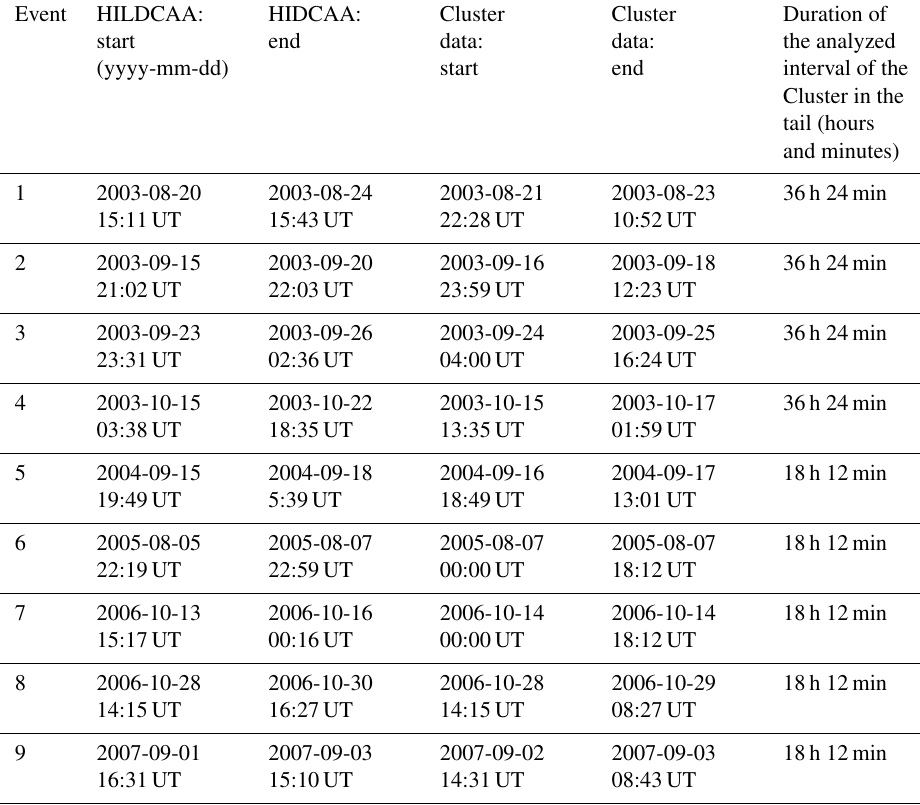
Table 1. B x geomagnetic field component data information used for the HILDCAA events analysis in the magnetotail. Event HILDCAA: HIDCAA: Cluster Cluster Duration of start end data: data: the analyzed (yyyy-mm-dd) start end interval of the